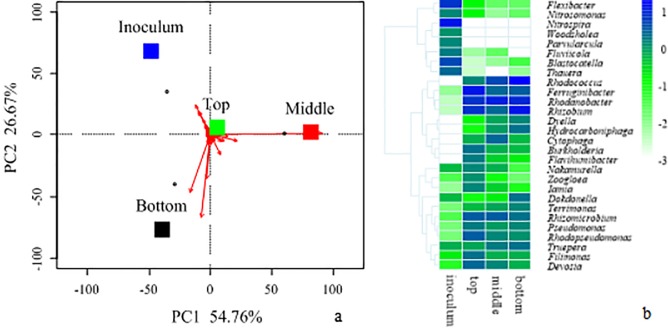
Principal component analysis (PCA) of bacterial communities from the initial inoculum and samples of the top, middle and bottom layers based on the classified OTUs (a). Heat map illustrating the abundances of all the major genera (with a relative abundance of more than 1% in at least one sample). The color intensity (log scale) in each panel indicates the relative abundance of the genus in each sample (b).